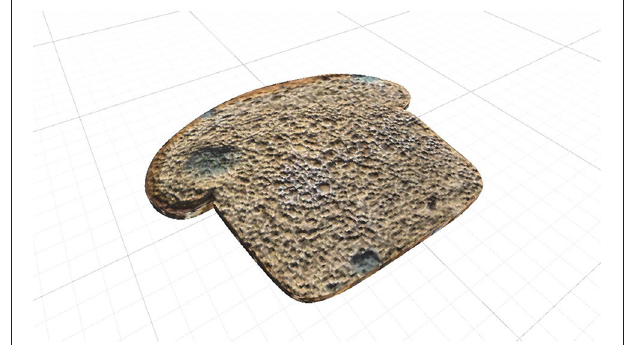
FIGURE 2 | Bread with